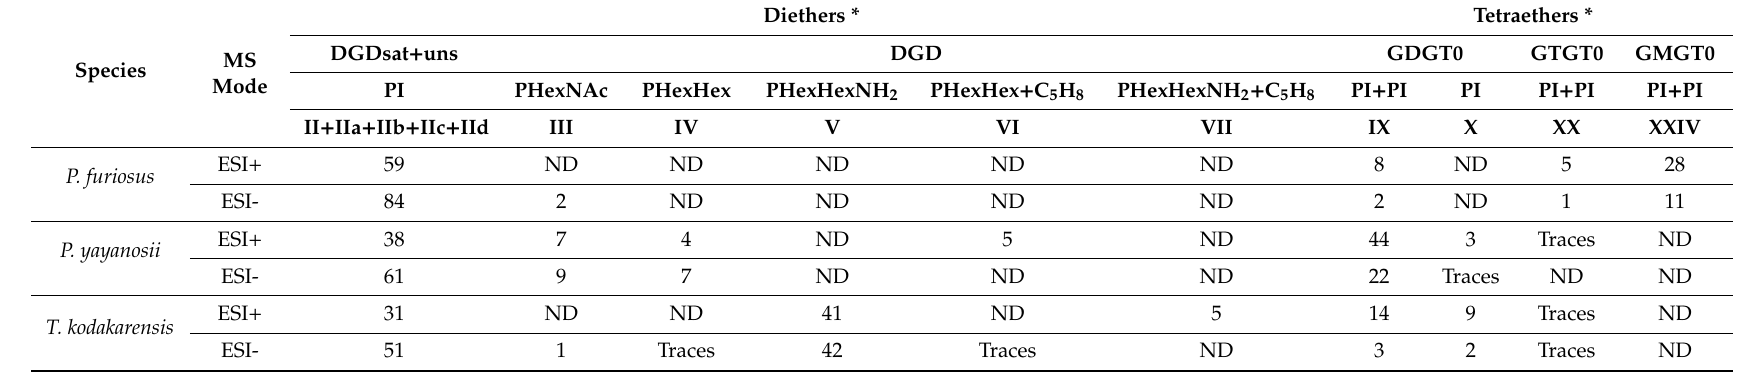
Table 1. Intact polar lipids (IPL) composition (relative %) of Pyrococcus furiosus , Pyrococcus yayanosii and Thermococcus kodakarensis .